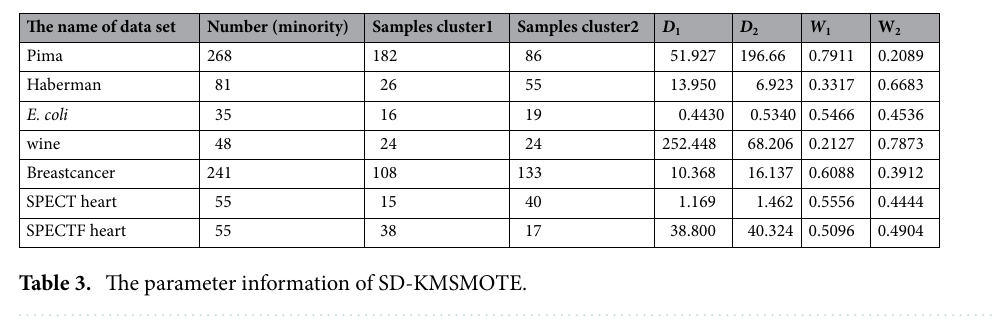
The name of data